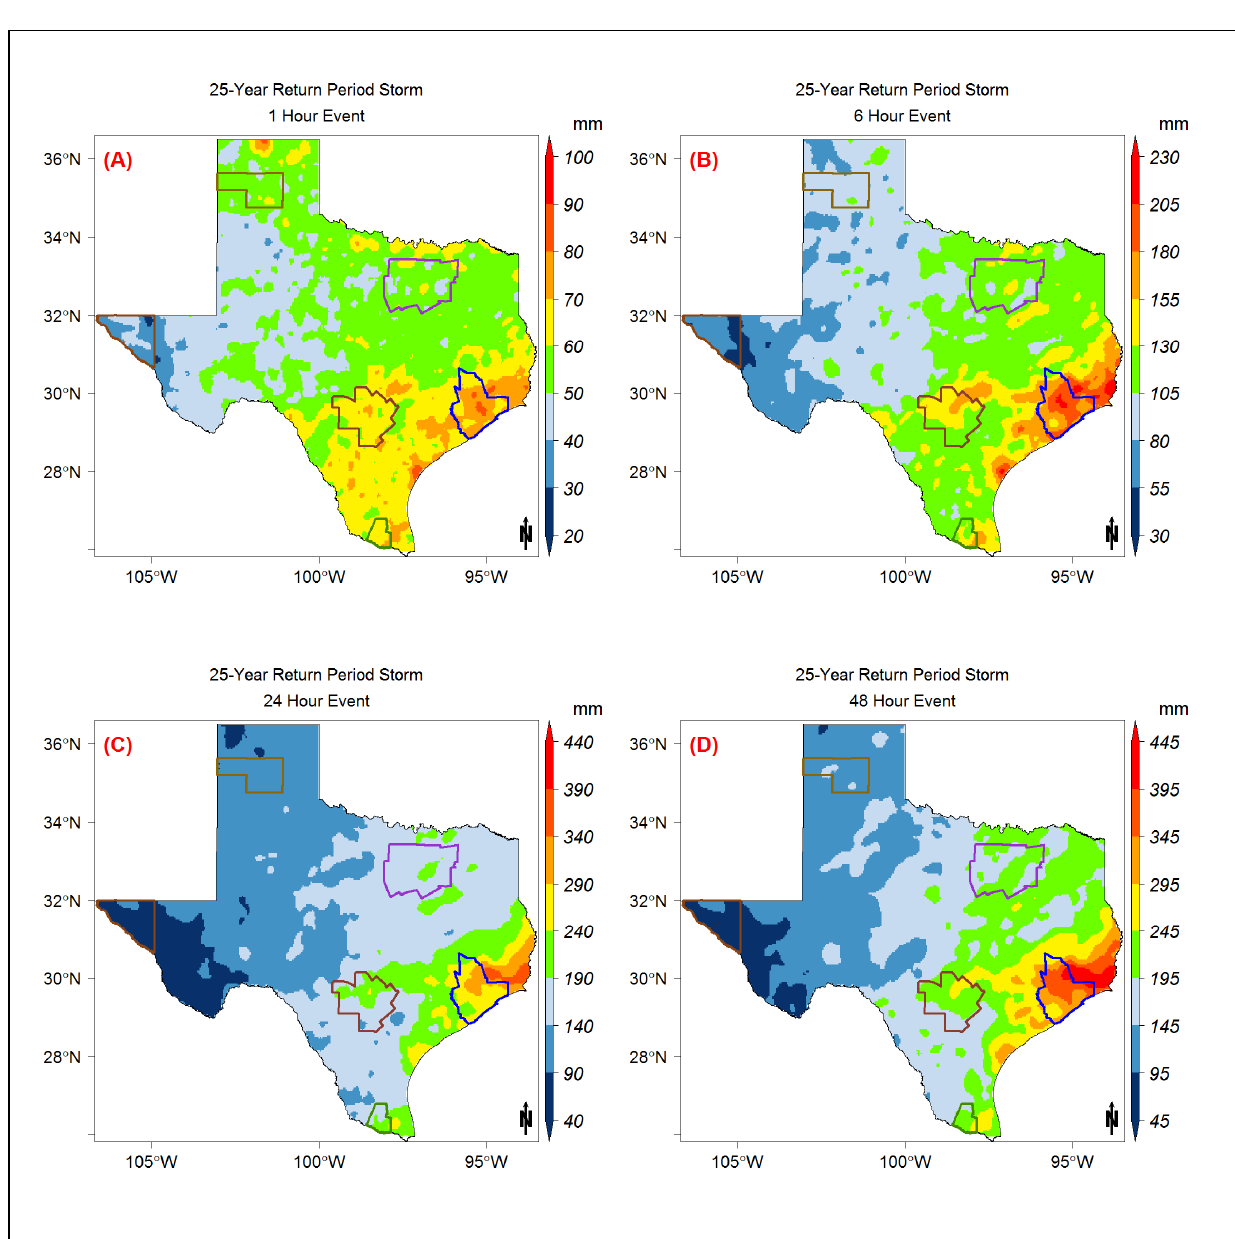
Figure A7. The 25-year return period storm event map modeled using the Gumbel model distribution for the ( A ) 01-h, ( B ) 6-h, ( C ) 24-h, and ( D ) 48-h storm durations.